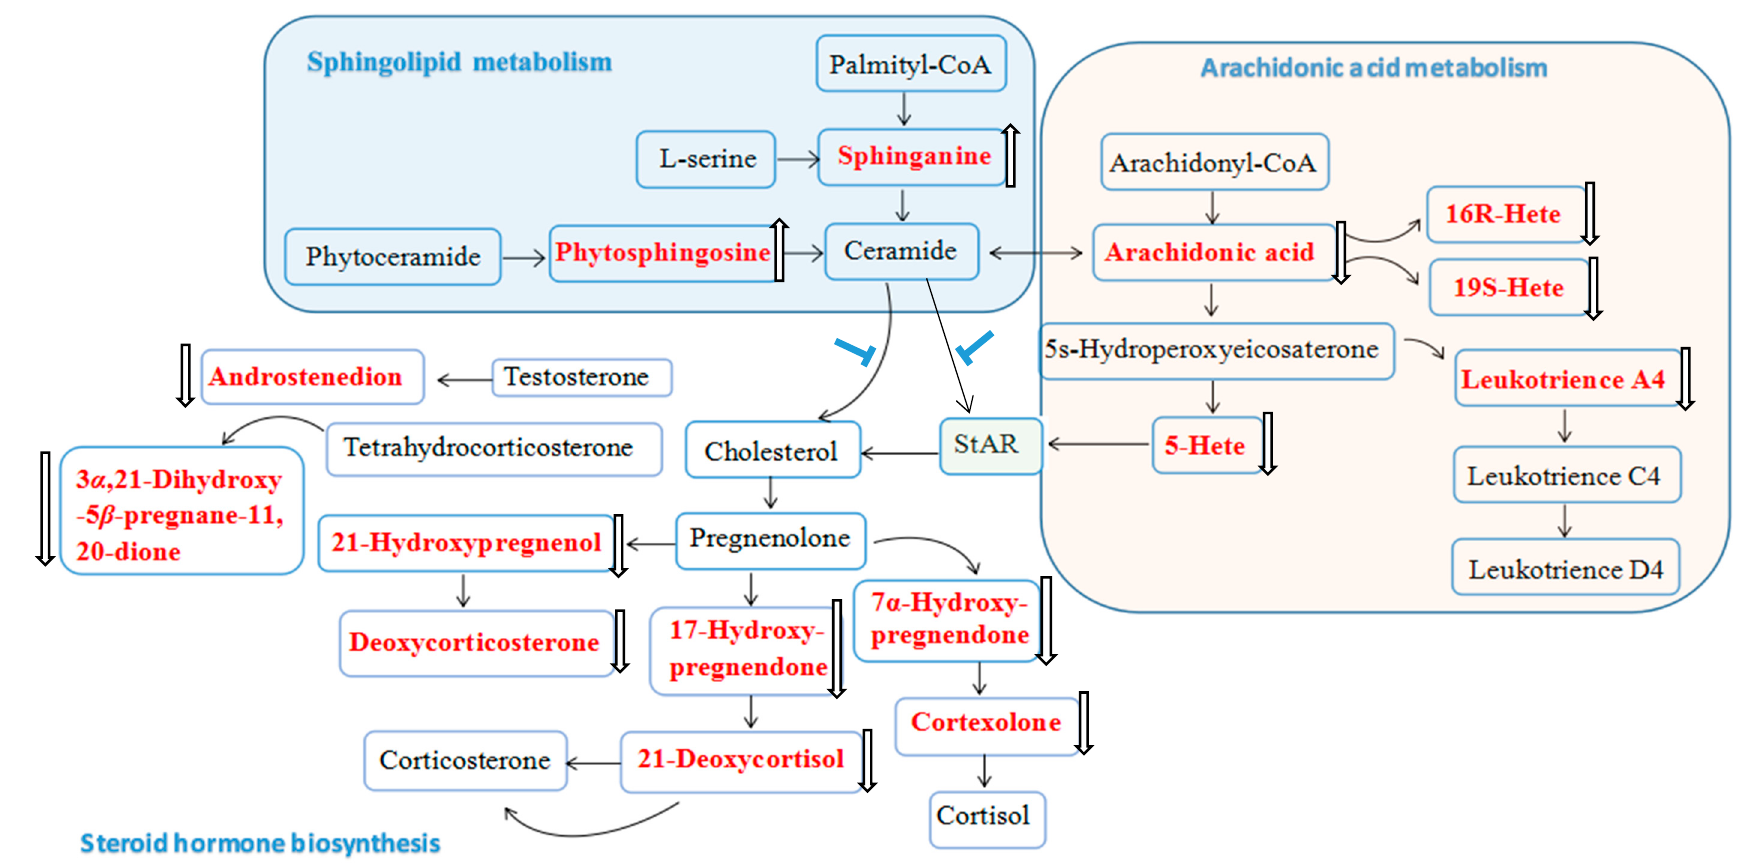
Figure 8. Correlation networks of potential markers in response to therapeutic effects of XXT on BSS rats according to the databases. The red marked metabolites refer to the detected potential biomarkers by UPLC-Q/TOF-MS technique ( : over-expressed in XT compared with BM; : down expressed in XT compared with BM; : inhibiting the expression of Cholesterol/StAR).